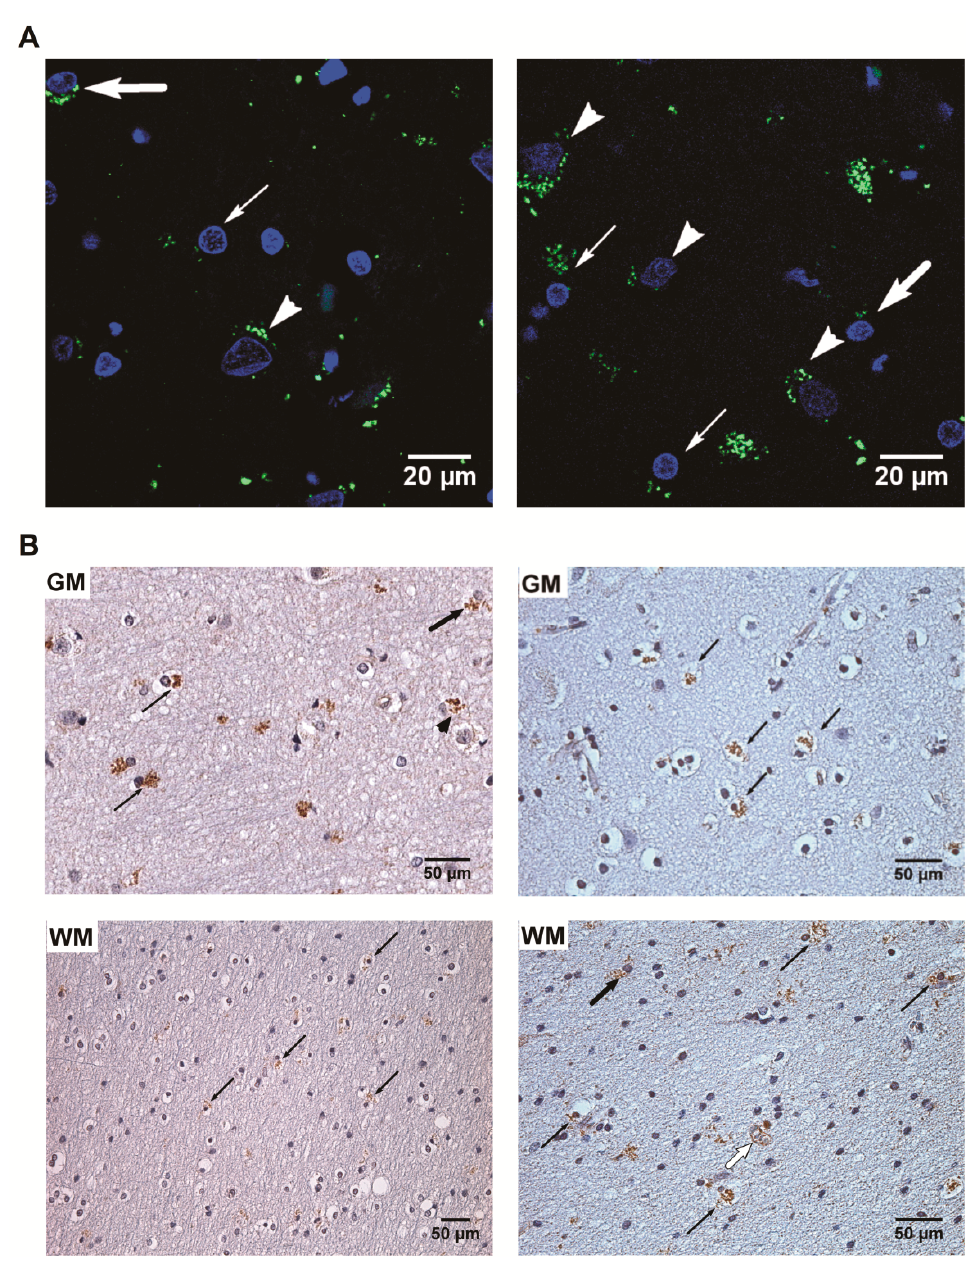
Figure 4. The presence of herpesvirus-6 (HHV-6) positive cells in the PCR+ samples: ( A ) detection of HHV-6 antigens by immunofluorescence, confocal microscopy (1000×), DAPI — blue, HHV-6 immunopositive products — green. Left: frontal gray matter — HHV-6 positive neuron (arrowhead), astrocyte (thick arrow), oligodendrocyte (narrow arrow) of the unspecified encephalopathy (UEP) subject; right: temporal gray matter — HHV-6 positive neuron (arrowhead), astrocyte (thick arrow), oligodendrocytes (narrow arrow) of the UEP subject; ( B ) detection of HHV-6 antigens by routine immunohistochemistry (IHC), HHV-6 immunopositive products — brown. Left: frontal gray (GM) and white (WM) matter of the UEP subject, neuron (arrowhead), astrocytes (thick arrow), oligodendrocytes (narrow arrow), (400×, 250×); right: temporal gray (GM) and white (WM) matter of the UEP subject, astrocytes (black thick arrow), oligodendrocytes (black narrow arrow), endotheliocytes (white thick arrow), (400×, 400×).